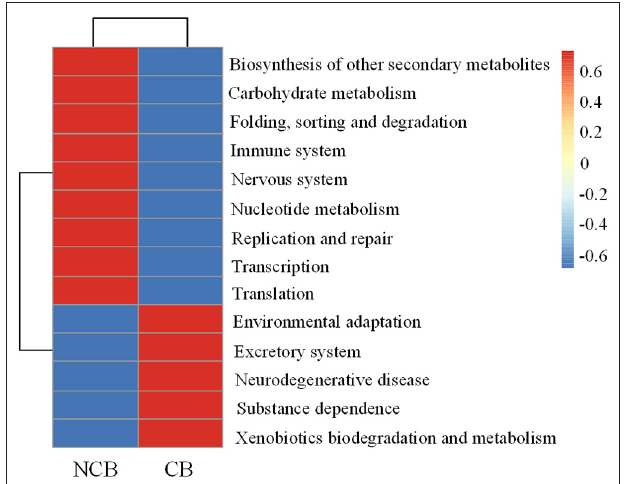
FIGURE 8 | Differences in KEGG functions in the B. aeruginosa gut microbial community during non-cyanobacterial bloom (NCB) and cyanobacterial bloom (CB) periods (level 2). ( P <